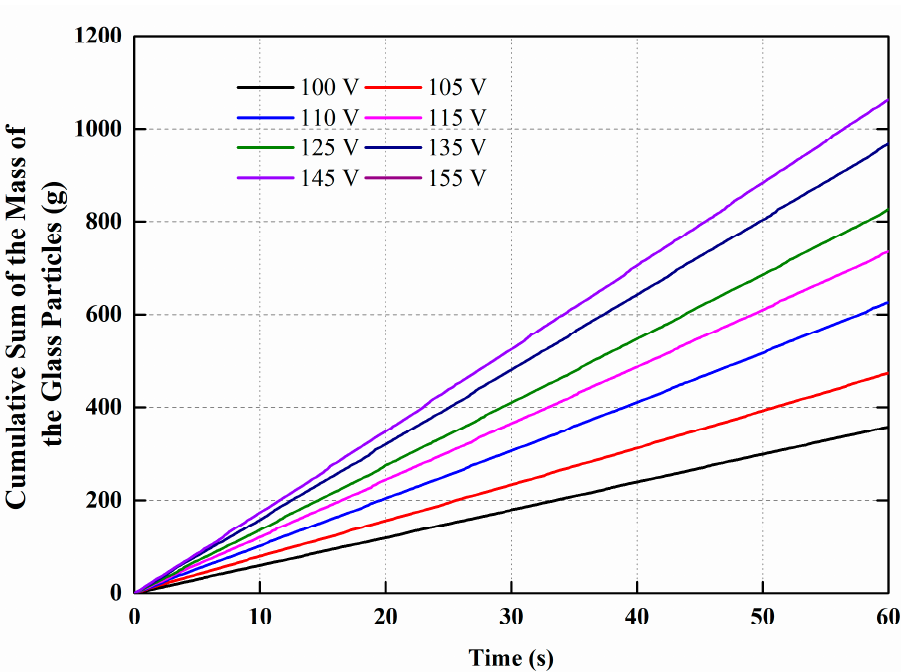
Figure 2. Consistency tests for the particle flow rates.